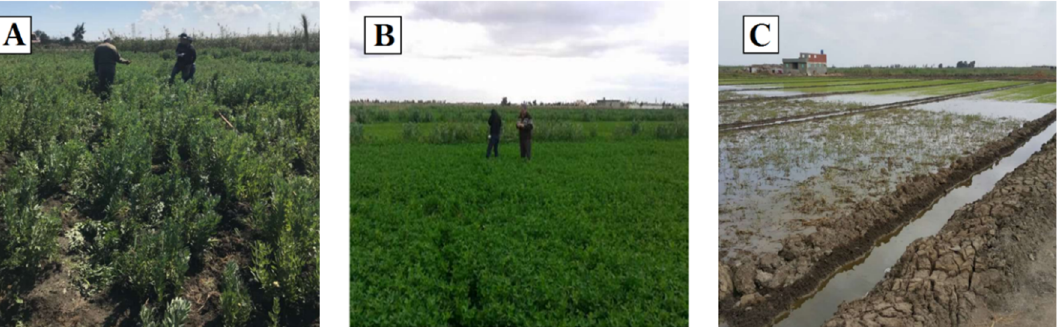
Figure 2. Agricultural conditions of the three investigated farms: ( A ) Heterogeneous and partially dead vegetation cover, ( B ) no deep-rooted plants can successfully grow, and ( C ) barren saline soil and frequent